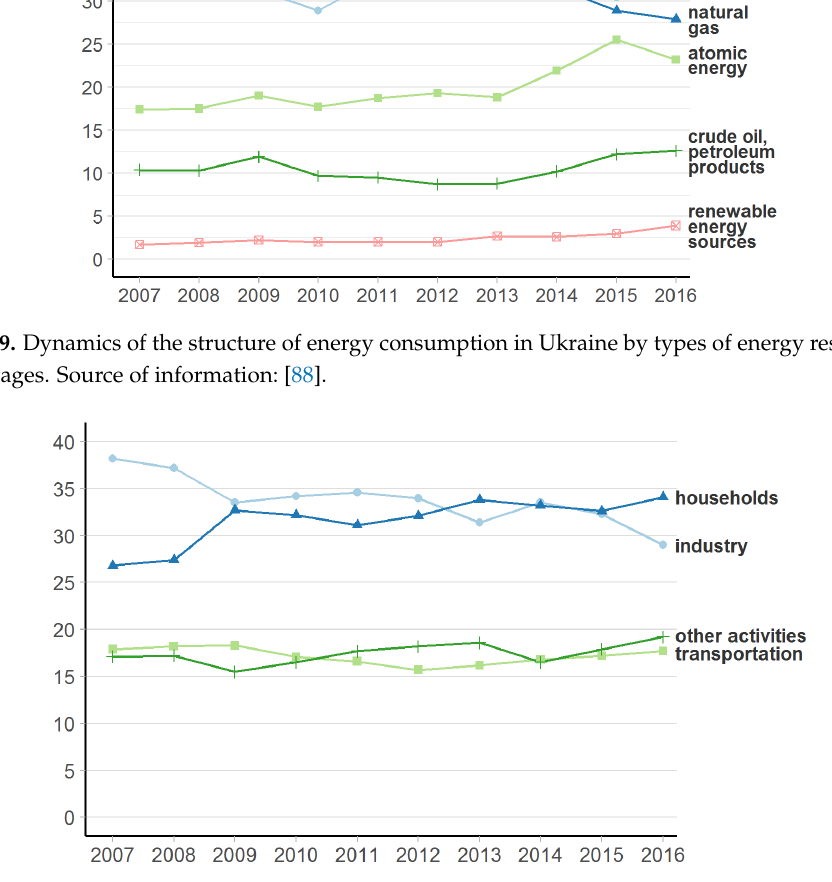
Figure 10. Dynamics of the final energy consumption structure in Ukraine by consumers types (%). Source of information: [88].